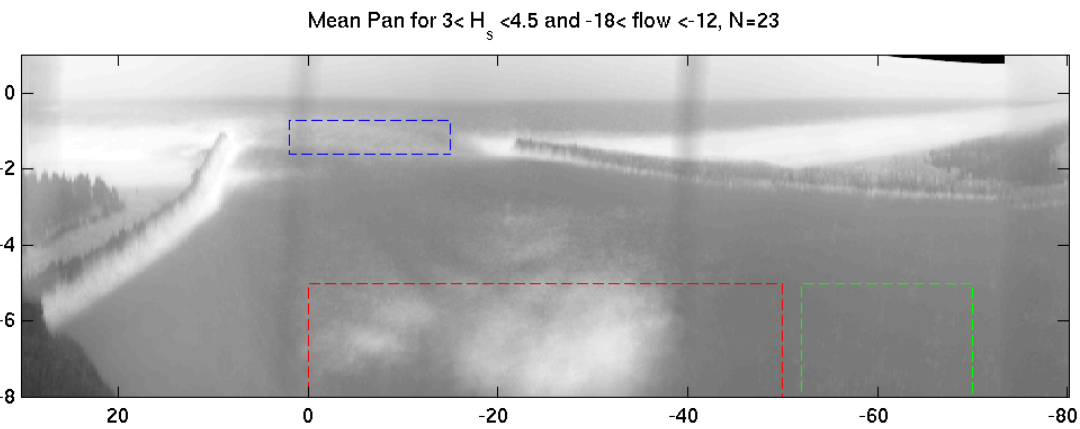
Figure 16. Mean intensity sampling regions. Red is the region of Guano Rock, blue shows the Offshore region, and green shows the intensity normalization region.